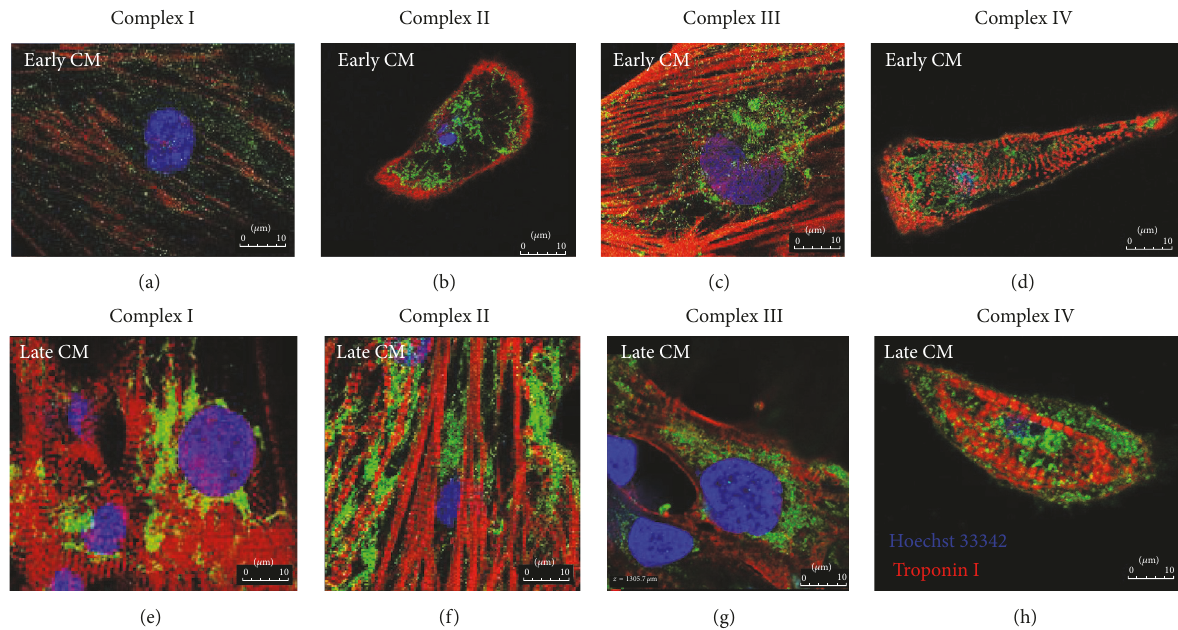
Figure 4: Immunofluorescence staining of mitochondrial respiratory Complexes I–IV (green), Troponin I (red), and Hoechst 33342 (blue) in early hPSC-CM (a–d) and late hPSC-CM